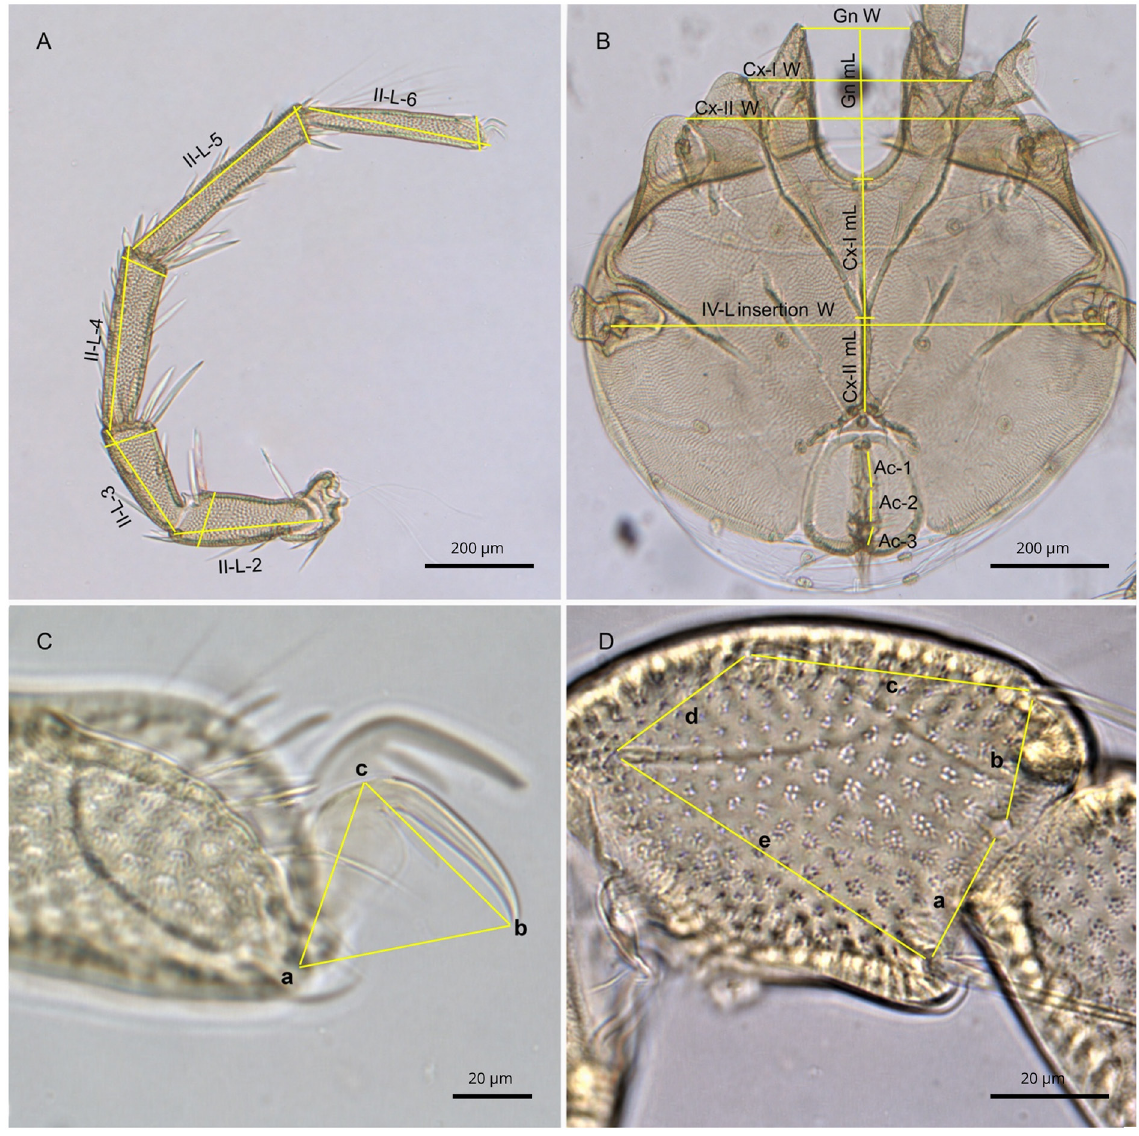
Fig. 3. Genus Lebertia Neuman, 1888, positions and shorthand labelling for morphological measurements. A . Example of segment length and height measurements for legs and palps. B . Measurements across the coxal shield. C . The dimensions of the claw; the centre of curvature (c) was defined to be the point opposite of the smaller claw. D . Distances among the long setae on the third segment of the palp. Abbreviations: Ac = acetabula; Cx = Coxa; Gn = gnathosomal bay; L = length; mL = median length; W = height; II-L = second leg. Roman numerals refer to the order of legs starting anteriorly, Arabic numerals refer to segment number starting proximally, for Ac starting